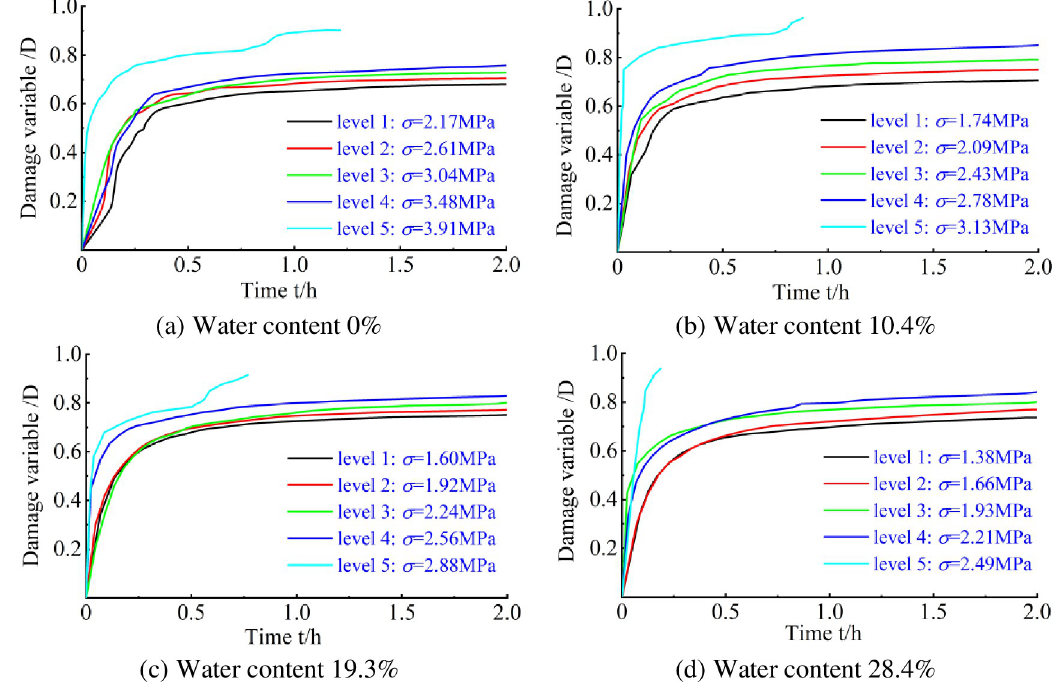
Fig 12. Damage variable curve based on elastic modulus. (a) Water content 0%, (b) Water content 10.4%, (c) Water content 19.3%, (d) Water content